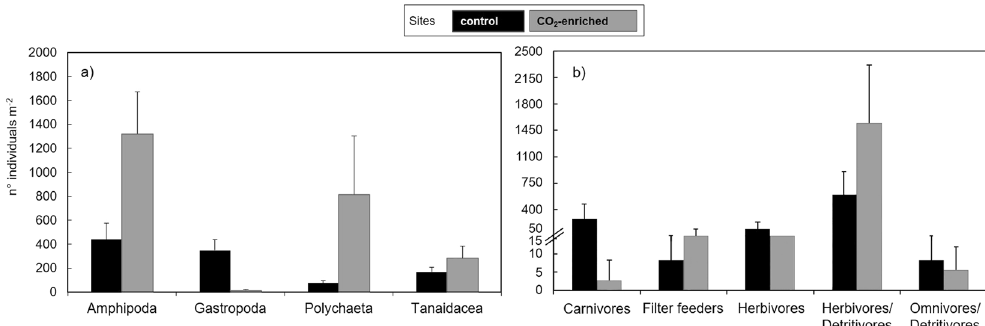
Figure 2. Abundance of the motile invertebrate taxa and trophic groups at the control (black) and CO 2 - enriched (grey) sites. Density (n° individuals m − 2 ; mean ± standard error) of ( a ) main taxa and ( b ) trophic group of the motile invertebrate